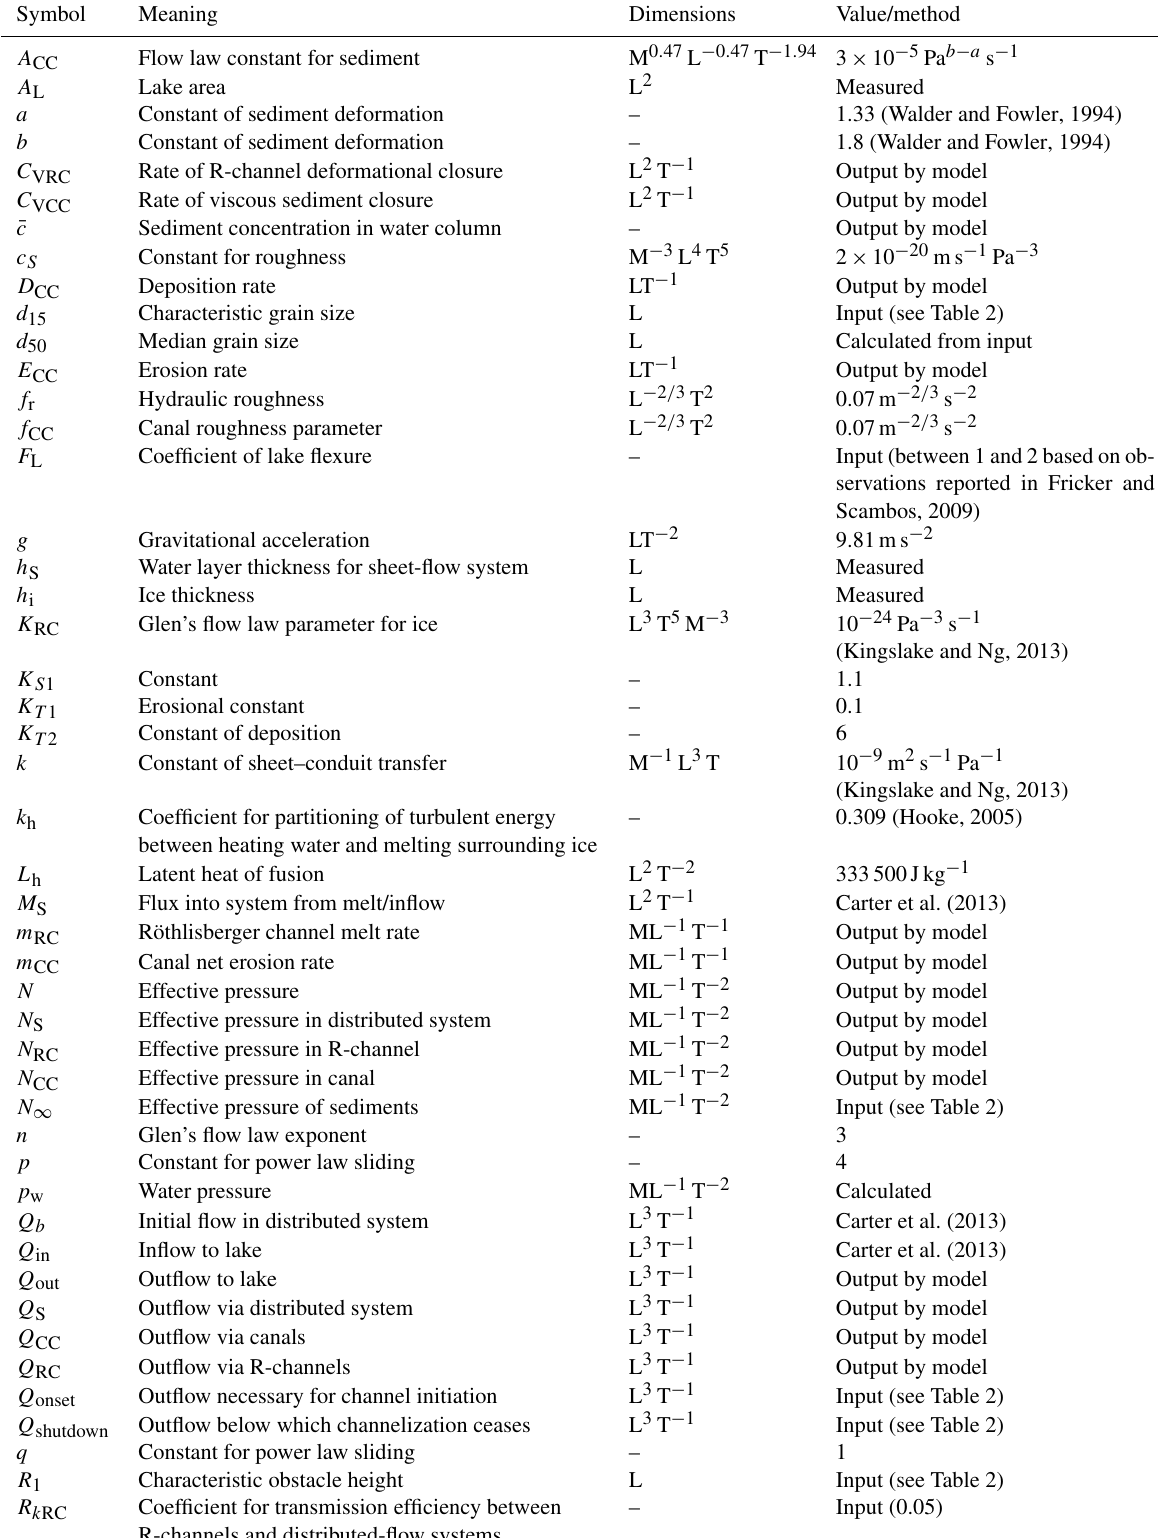
Table 1. List of all symbols used in this paper with definitions, dimensions, and value/method used to estimate them. Symbol